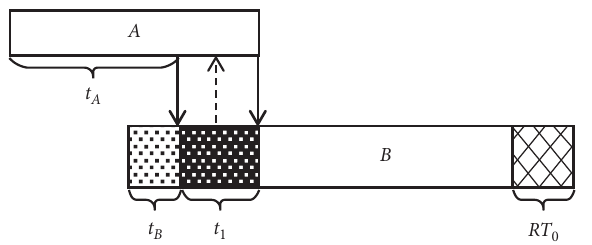
Figure 4: Information flow interaction between overlapping